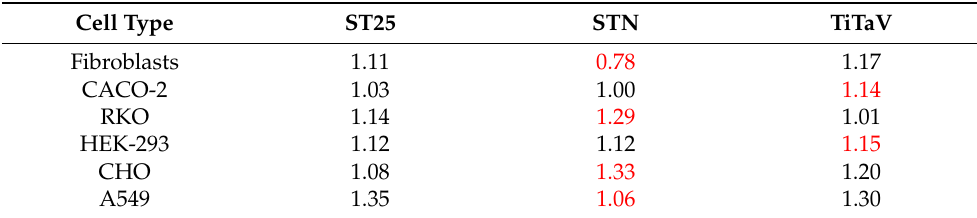
Table 1. Hypothetical matrix of the sensor responses to the six culture cells plated at 250 K cells/dish after 48 h of